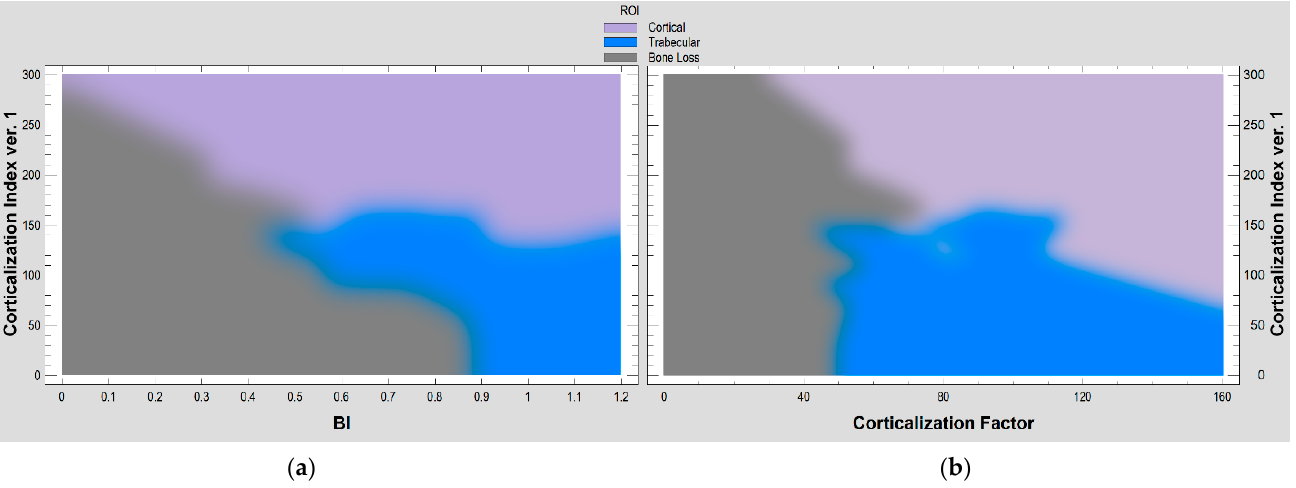
Figure 8. The relationships of selected corticalization measures in the evaluation of intraoral radio- graphs. ( a ) Corticalization index ver.1 with bone index (BI). A probabilistic neural network (PNN) used to classify cases into different three structures in radiograph (cortical, trabecular, bone loss), based on two input variables (corticalization index ver.1 and bone index). Of the 120 ROIs, 93% were correctly classified by the network. ( b ) Corticalization index ver.1 with corticalization factor. Among the 120 ROIs used, 94% were correctly classified in this pair of corticalization evaluators.